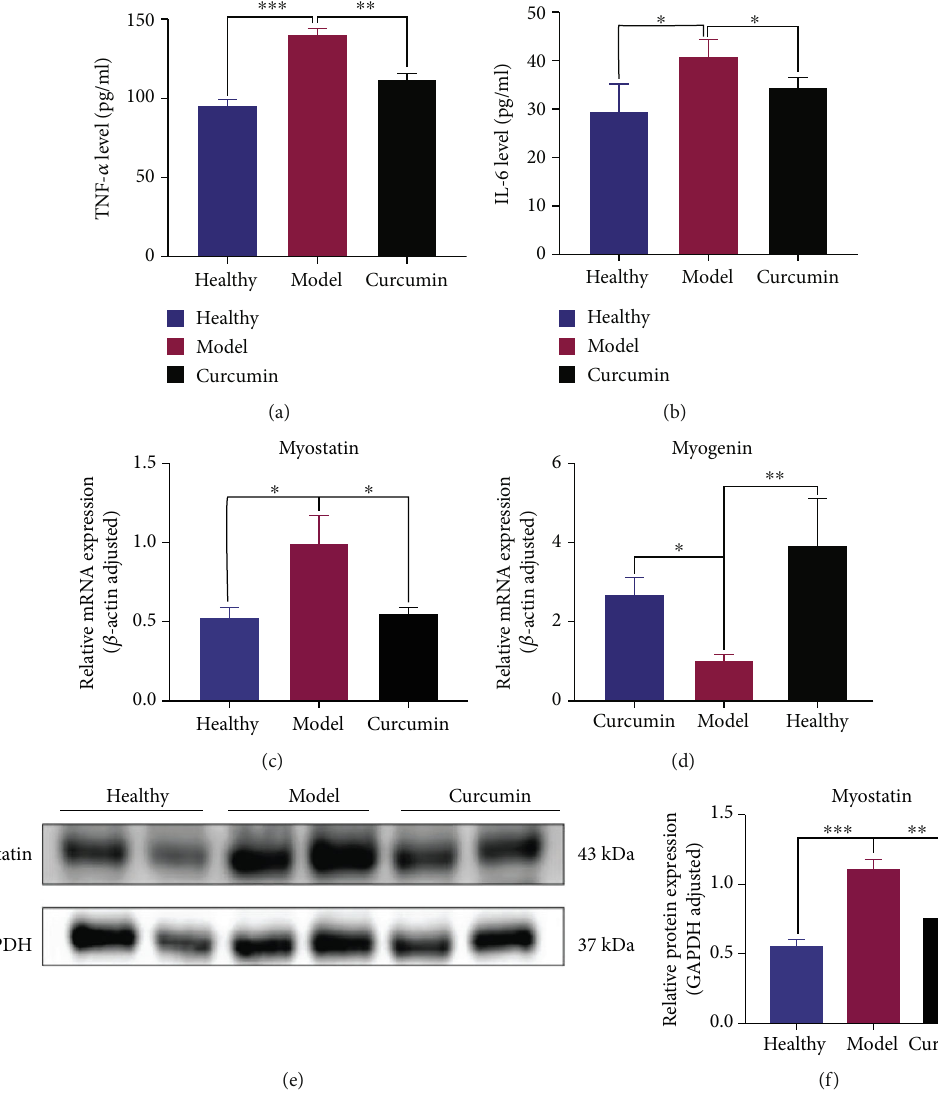
Figure 7: Curcumin decreased in fl ammatory factors, increased the expression of myogenic factors, and decreased the expression of myodegradable factors in the muscle tissue of tumor-bearing mice. (a, b) Statistical analysis of TNF- α and IL-6 levels in gastrocnemius of three groups of mice ( n = 4 /group). (c, d) Statistical analysis of myostatin and myogenin mRNA expression in gastrocnemius of mice in three groups. (e, f) Statistical analysis of myostatin and myogenin protein expression di ff erence in gastrocnemius of the three groups. NS: not signi fi cant; ∗ p < 0 : 05 , ∗∗ p < 0 : 01 , and ∗∗∗ p < 0 : 001 by t -test, compared to the model group. Data was shown as mean ± standard errorsof themean